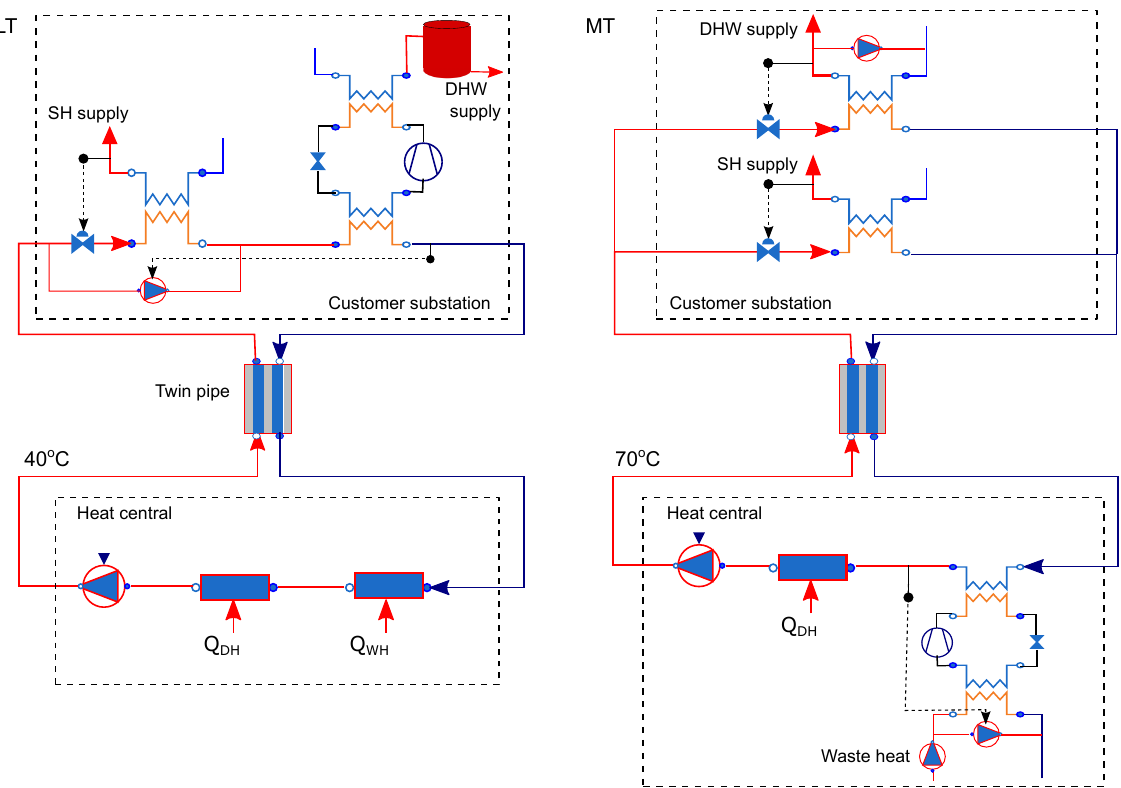
Figure 3. A schematic of the heat centre coupled to one substation with a twin pipe in between for the LT and MT supply